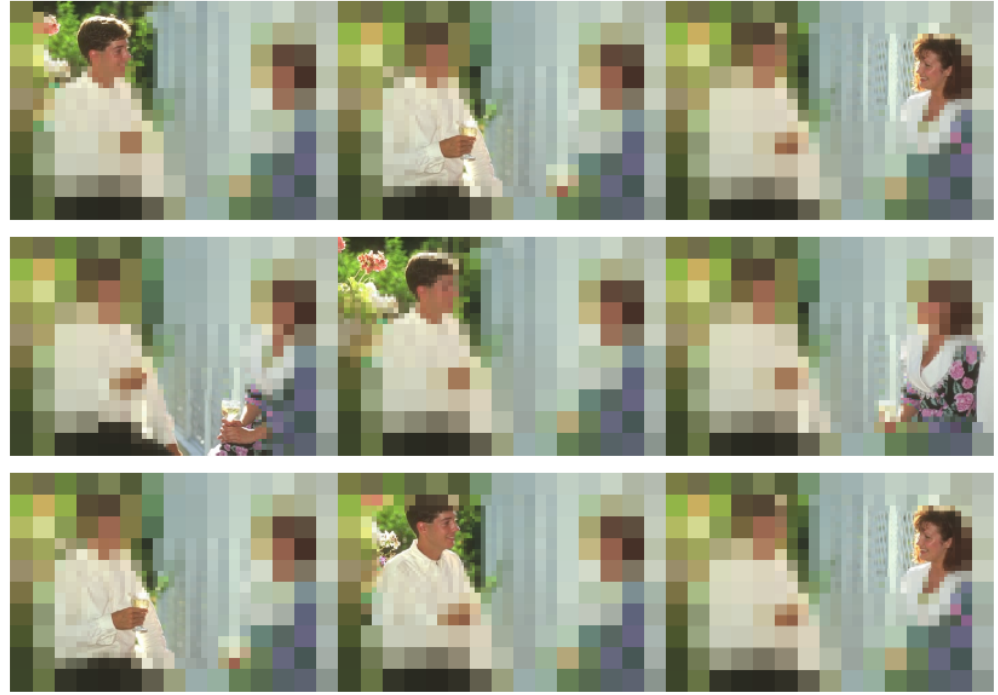
Figure 18. Active exploration of Image #157055 of the BSDS500: from the top-left corner to the bottom-right, the figure shows the sequence of